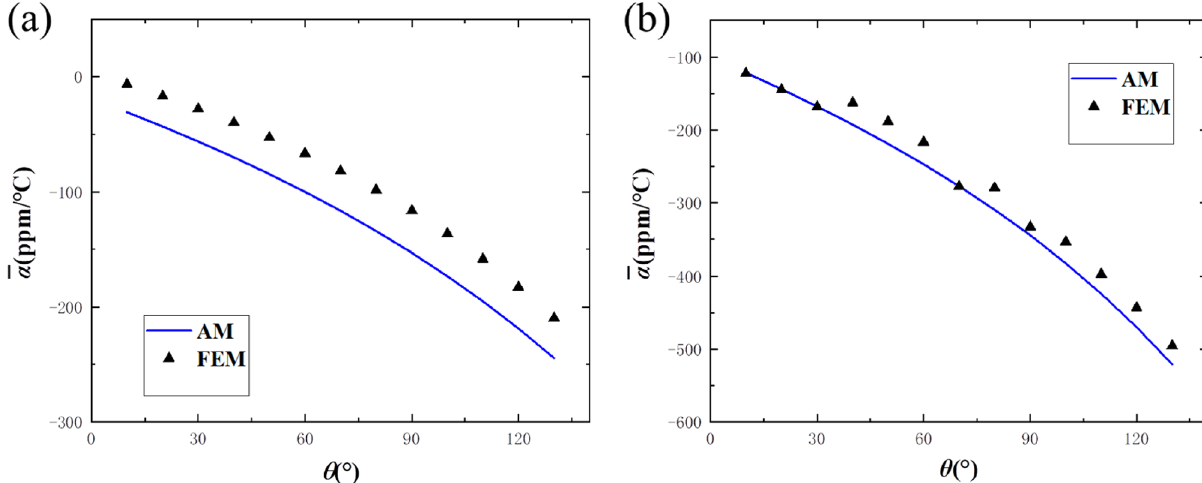
Figure 12. Comparison between theoretical formula and finite element method of the proposed metamaterials: ( a ) chiral structure; ( b ) anti-chiral